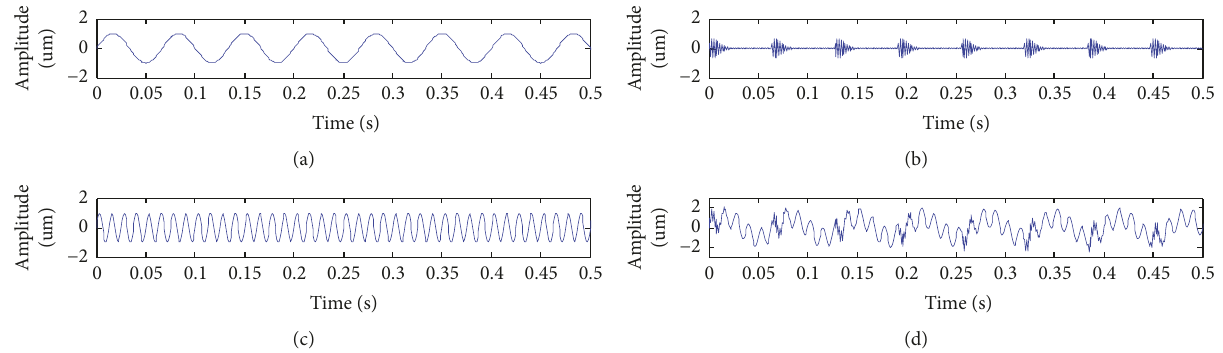
Figure 2: Simulation signal and its constituents: (a) low-frequency sinusoidal wave, (b) impact component, (c) high-frequency sinusoidal wave, and (d) simulation signal.